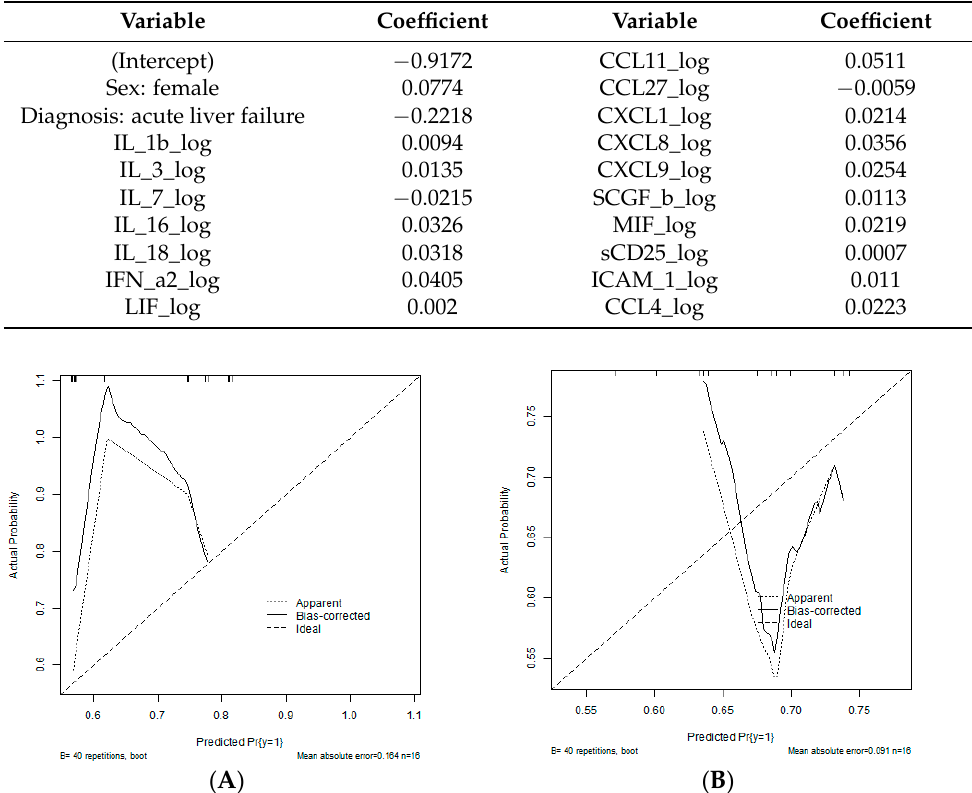
Table 5. Cytokines included into a diagnostic model derived from elastic net regression.